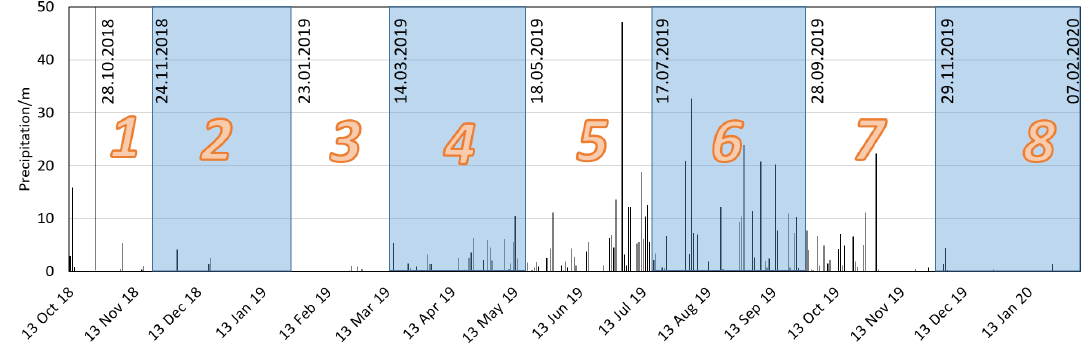
Figure 6. Daily precipitation of the Baiyu meteorology station from October 2018 to February 2020.